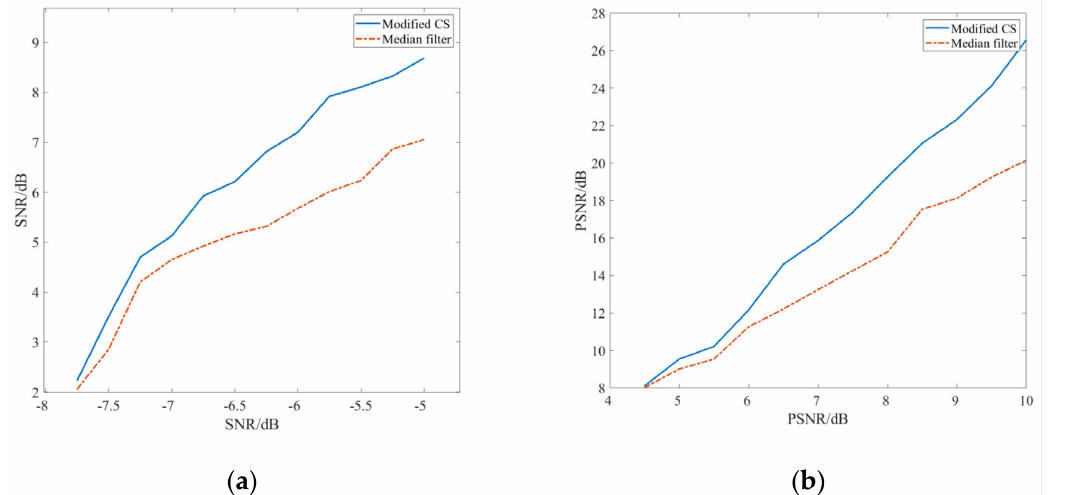
Figure 8. Comparison of denoising effect of different noise levels. ( a ) Multi-SNR levels denoising curves. ( b ) Multi-PSNR levels denoising